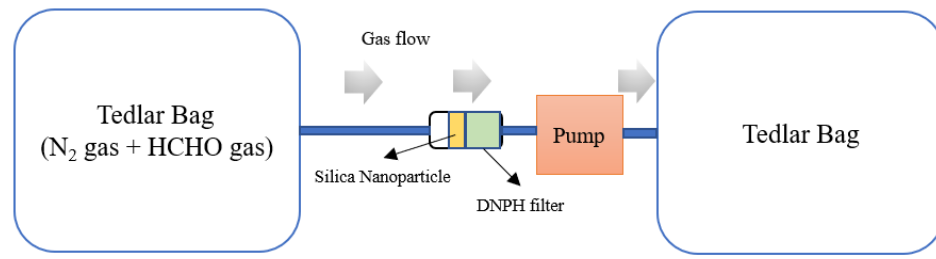
Figure 8. Schematic figure of HPLC setting for analyzing formaldehyde adsorption.